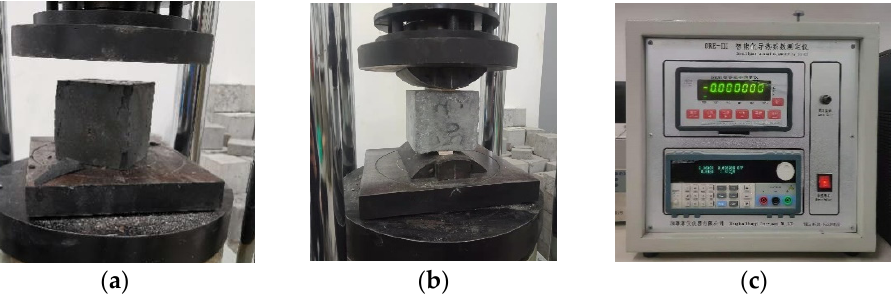
Figure 2. The test apparatus and loading: ( a ) compressive strength; ( b ) split tensile strength; ( c ) thermal conductivity.